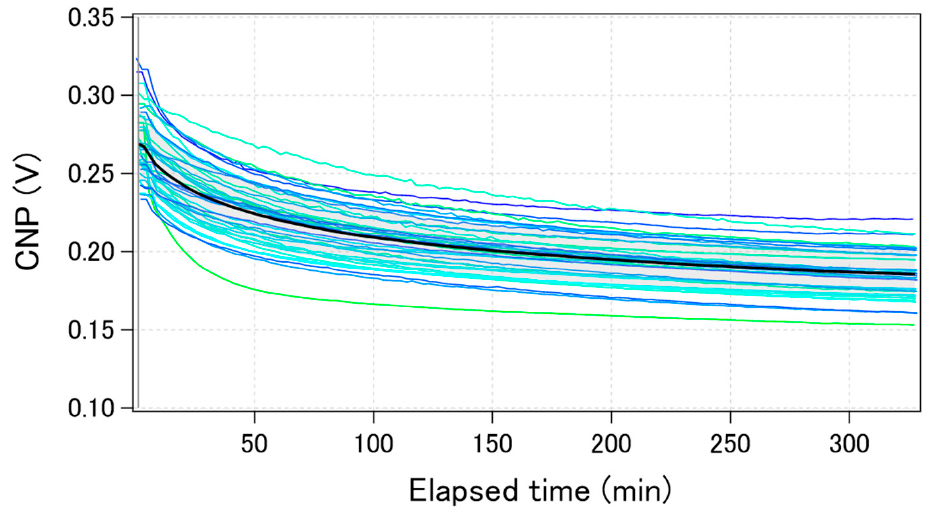
Figure 5. Time-course of the calculated CNPs during electric measurements for the same 40 GFETs in Figure 3. The black bolded line shows the calculated average value.